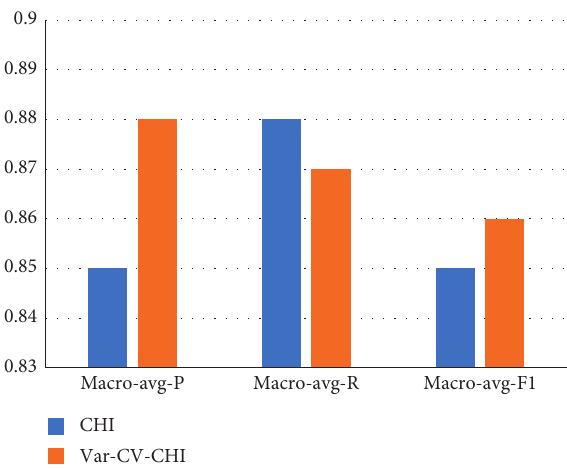
Figure 4: Comparison of macroresults between CHI and Var-CV- CHI on the unbalanced Chinese corpus (KNN). Table 6: Comparison of classification results between CHI and Var-CV-CHI on the balanced Chinese corpus (Na¨ıve Bayes).